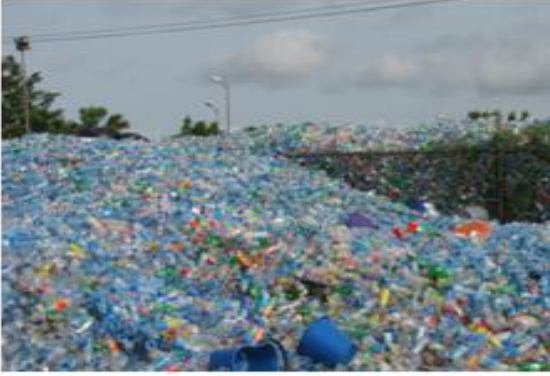
Figure 6. Collection site for all used PET bottles.